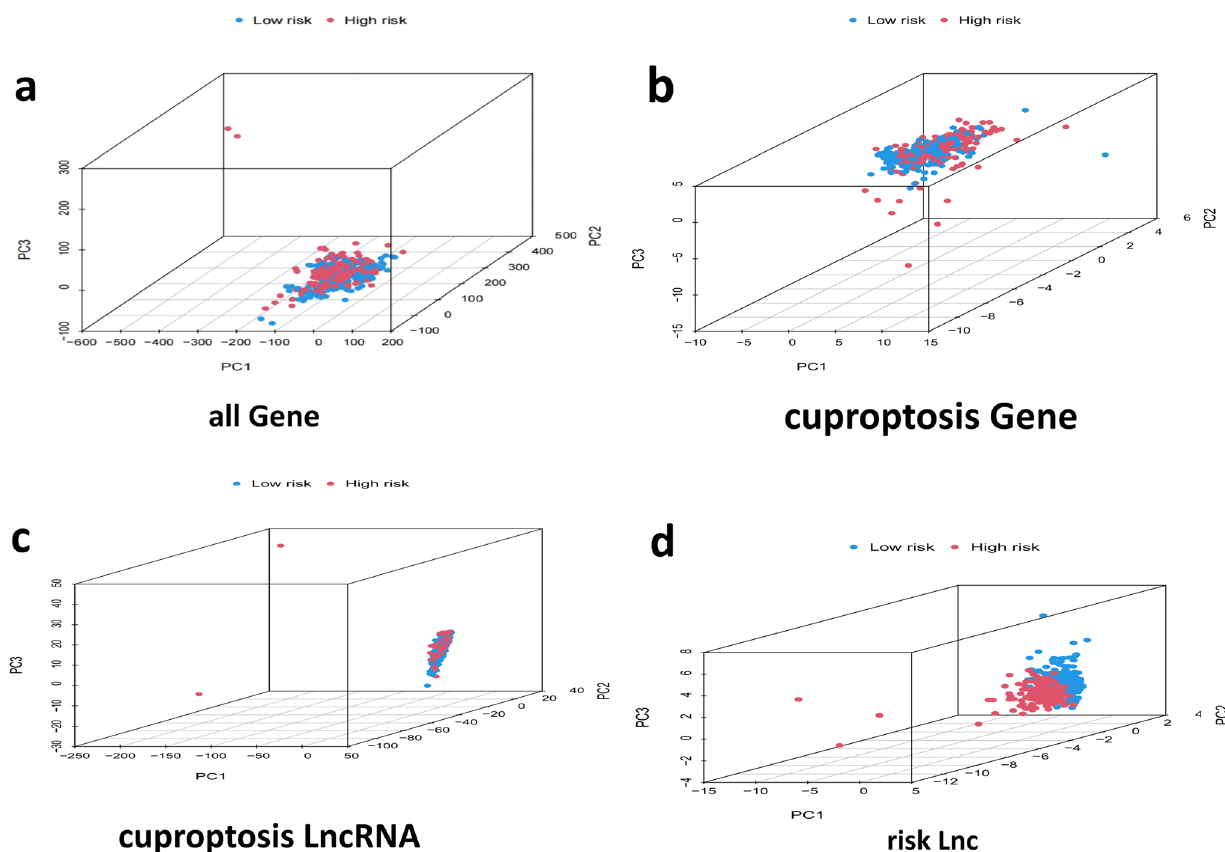
Fig. 8 PCA analysis of different model groups in high—and low-risk patients a all gene group. b cuproptosis gene group. c cuproptosis lncRNA group. d risk lnc group. Explanation: PCA analysis results of 9-CRLs signature, which has a good degree of distinction and prediction effect between high- and low-risk